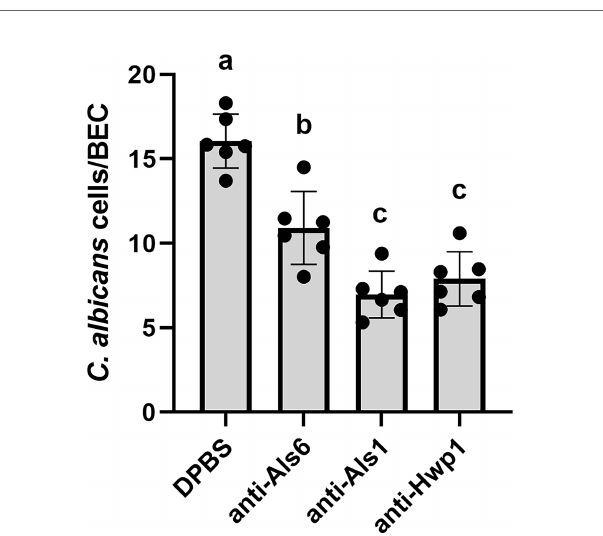
FIGURE 8 | Assessing the ability of anti-Hwp1 MAb 2-E8 to block C. albicans adhesion to freshly collected human BECs. DPBS, negative-control protein (anti-Als6), anti-Als1, or anti-Hwp1 were added to fl asks containing C. albicans CAI12 germ tubes and freshly collected human BECs. Following incubation for 30 min, cells were collected by fi ltration and transferred to glass microscope slides. The total number of germ tubes adherent to the fi rst 50 BECs visualized was counted. Data displayed in the histogram are mean ± standard deviation from duplicate assays conducted on three independent days. The effect of treatment was signi fi cant in the analysis (P = 0.0003). Lowercase letters indicate statistical signi fi cance groups. The DPBS treatment was signi fi cantly different from anti-Als6 (P = 0.0015), from anti-Als1 (P < 0.0001), and from anti-Hwp1 (P = 0.0001). The anti-Als6 treatment was signi fi cantly different from anti-Als1 (P = 0.0054) and anti-Hwp1 (P = 0.0176). The anti-Als1 and anti-Hwp1 treatments were not signi fi cantly different from each other (P = 0.3573). Addition of protein (anti-Als6) was suf fi cient to decrease adhesion compared to DPBS alone. Addition of anti-Als1 or anti- Hwp1 further decreased adhesion indicating that each MAb blocked the adhesive interaction between C. albicans germ tubes and human